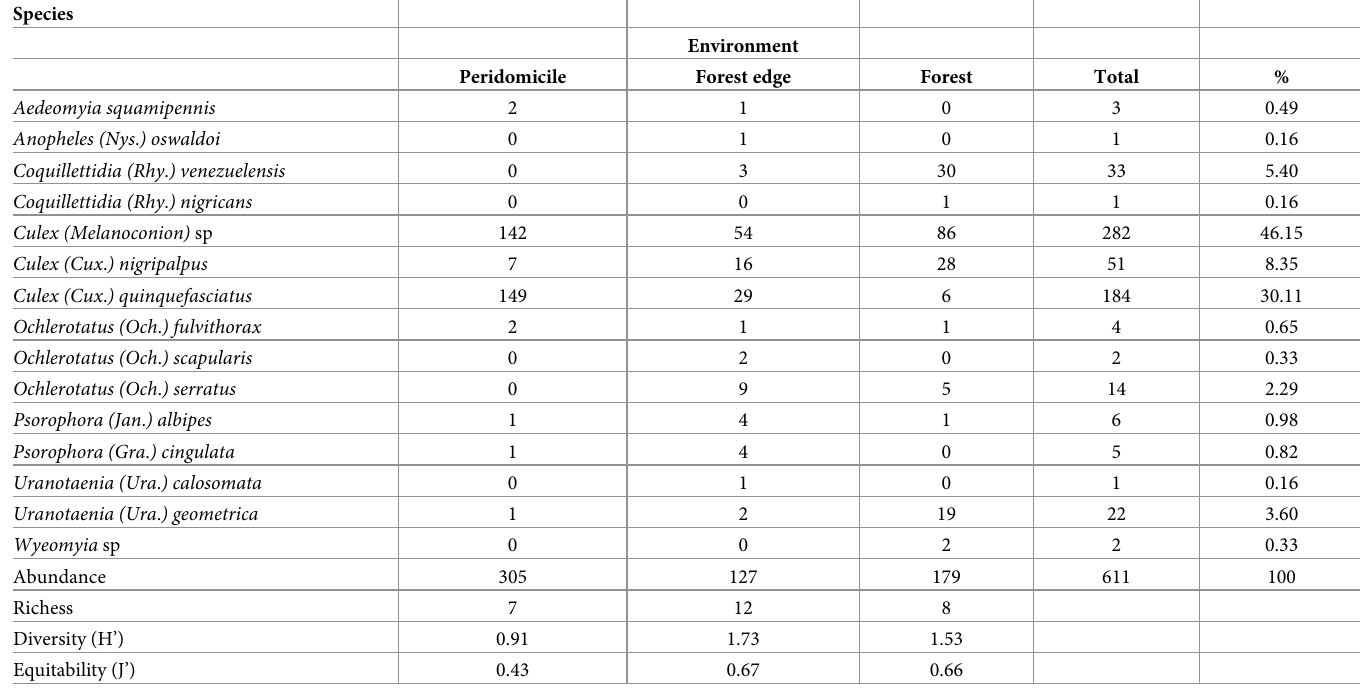
Table 2. Number of mosquitoes collected in the horizontal stratification transect by HP traps on six roads in the rural settlement of Rio Pardo, Presidente Figuei- redo, Amazonas, Brazil, in 2016.